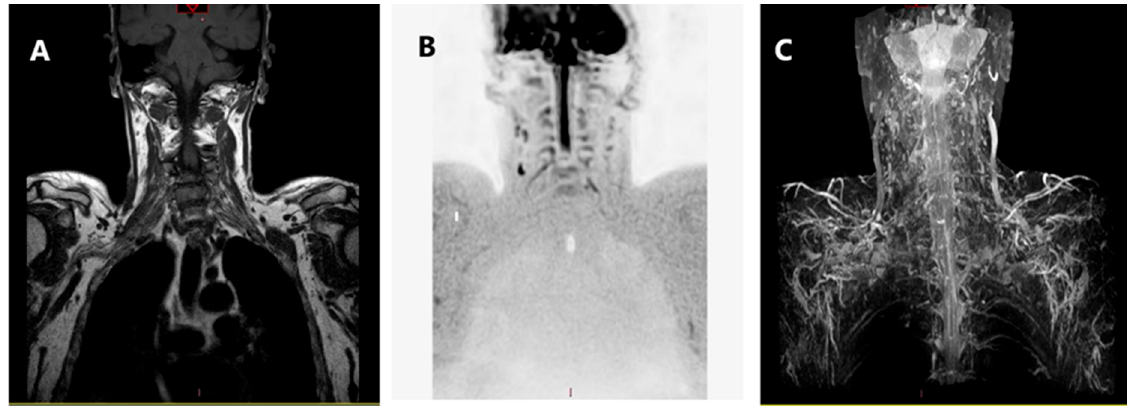
Figure 2. MRI sequences: ( A ) turbo spin-echo (TSE) T1 cor, ( B ) DWIBS, and ( C ) 3D STIR mip .